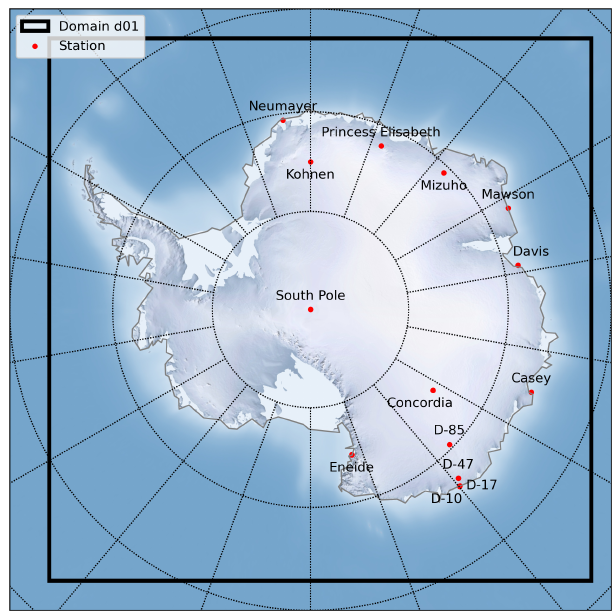
Figure 4. Simulation domain for case study Ia (black rectangle). The simulation domain encompasses the entire continent. Addition- ally, measurement stations used for model verification are repre- sented by red